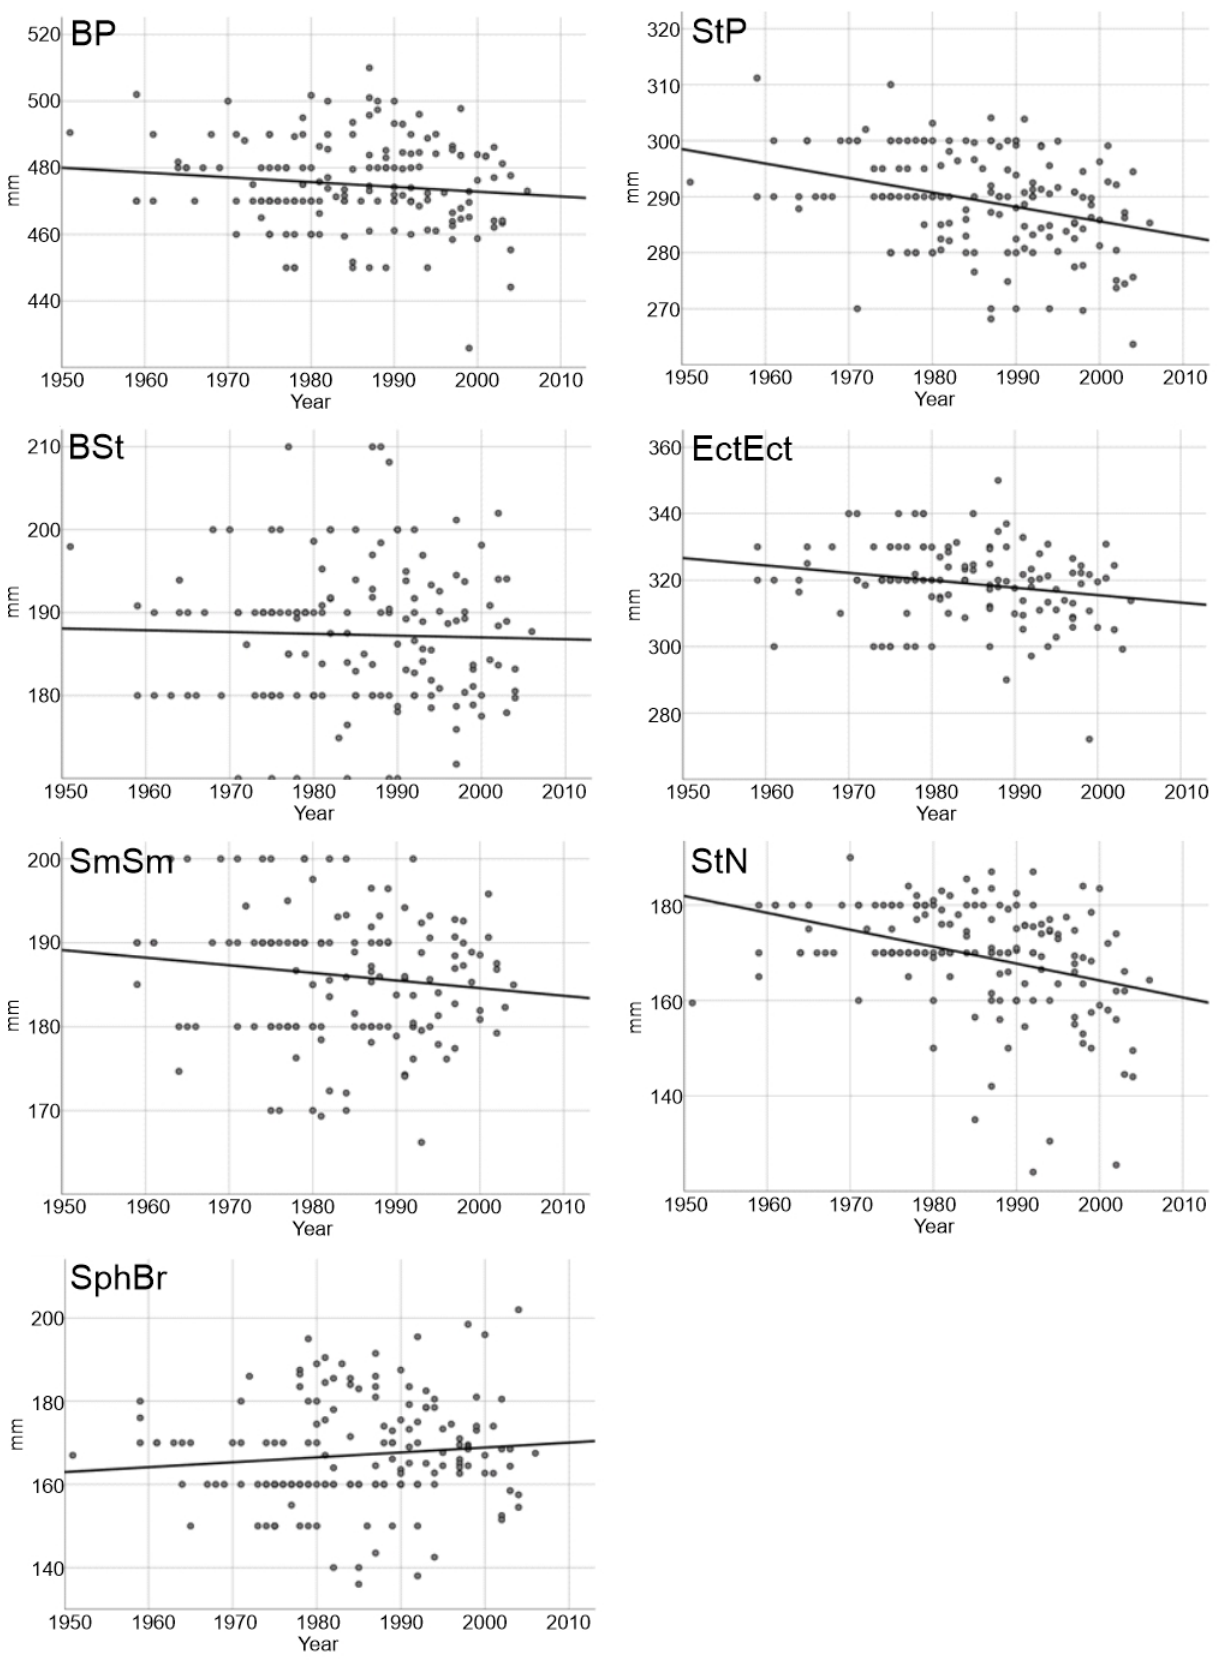
Figure 3. Trends in cranial dimensions change over time in males of European bison.